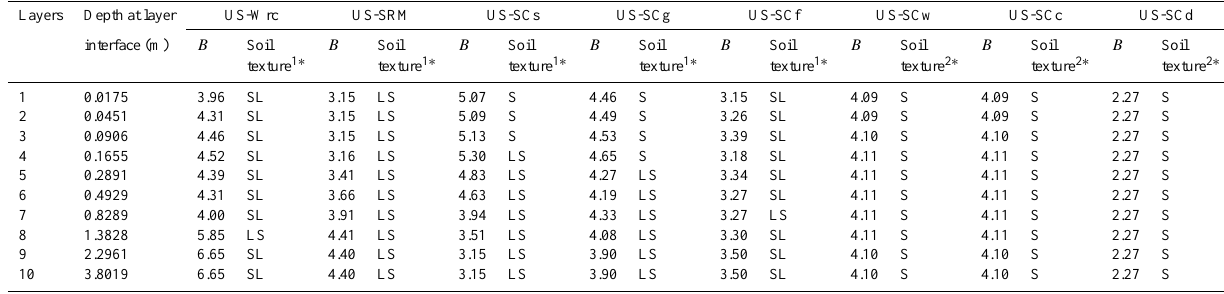
Note: 1 ∗ -derived from soil sample data in former studies; 2 ∗ -estimated by UCI Goulden Lab. “S” represents sand, “LS” loamy sand, and “SL” sandy loam. B values for sand, loamy sand, and sandy loam were 2.27–5.83, 2.91–5.85, and 3.15–6.65 in Clapp and Hornberger (1978), respectively.